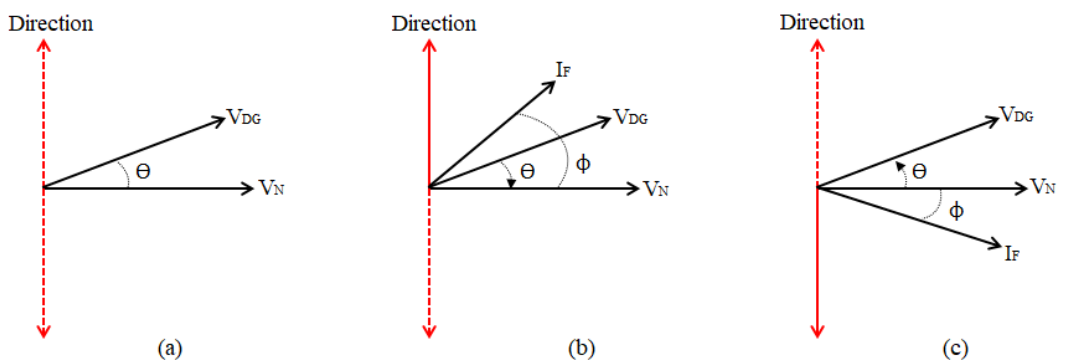
Figure 5. Phasor representation on estimating the direction of fault current, ( a ) normal operation of system, ( b ) forward flow of current with respect to fault location, ( c ) reverse current flow with respect to location of